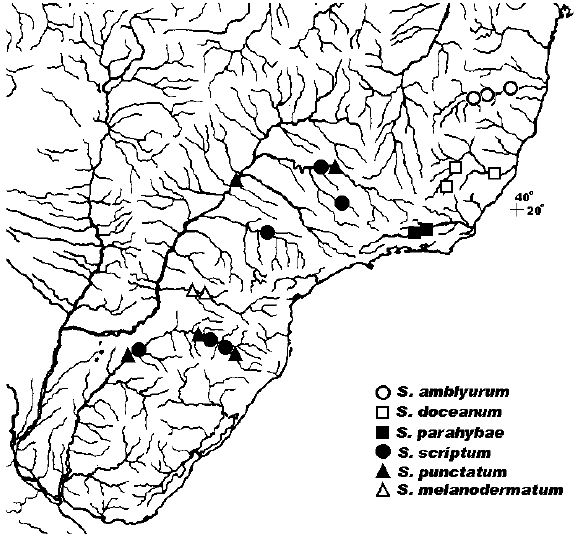
Fig. 1. Southeastern South America with the geographical distribution of Steindachneridion species. Each symbol may represent more than one